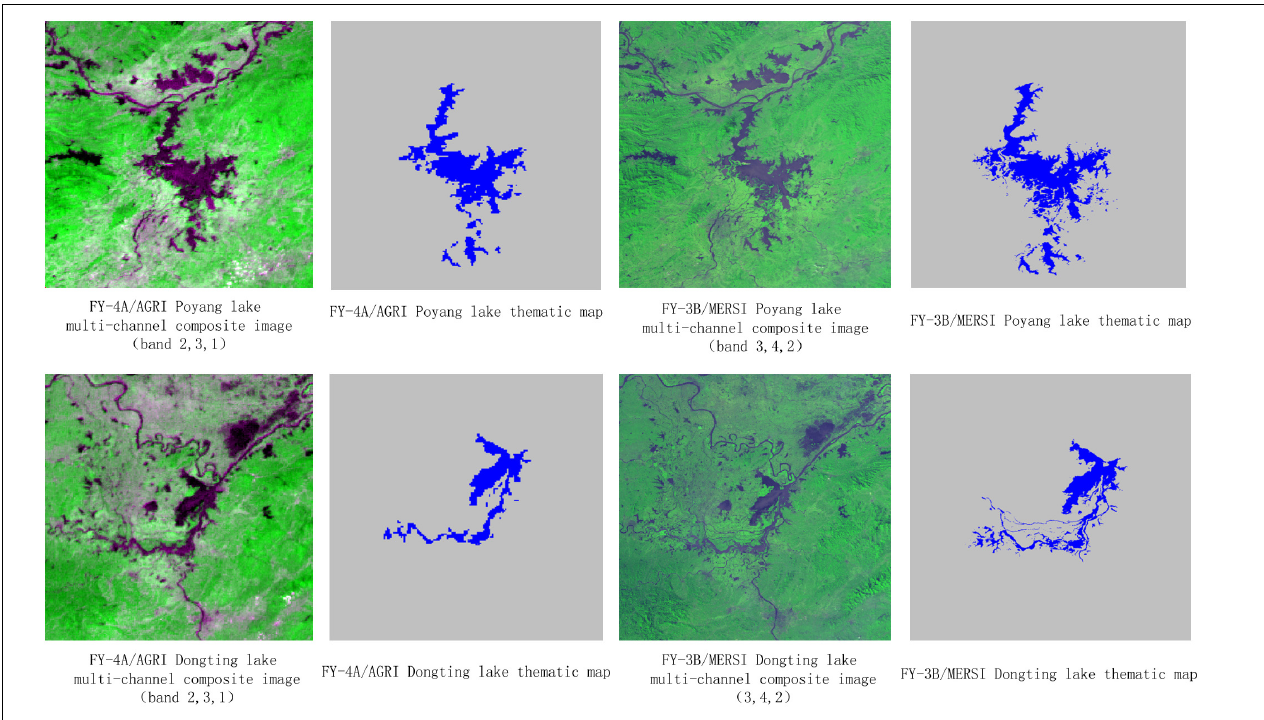
FIGURE 9 | Monitoring of Poyang and Dongting lakes using FY-4A/AGRI and FY-3B/MERSI data, 30 October 2017.